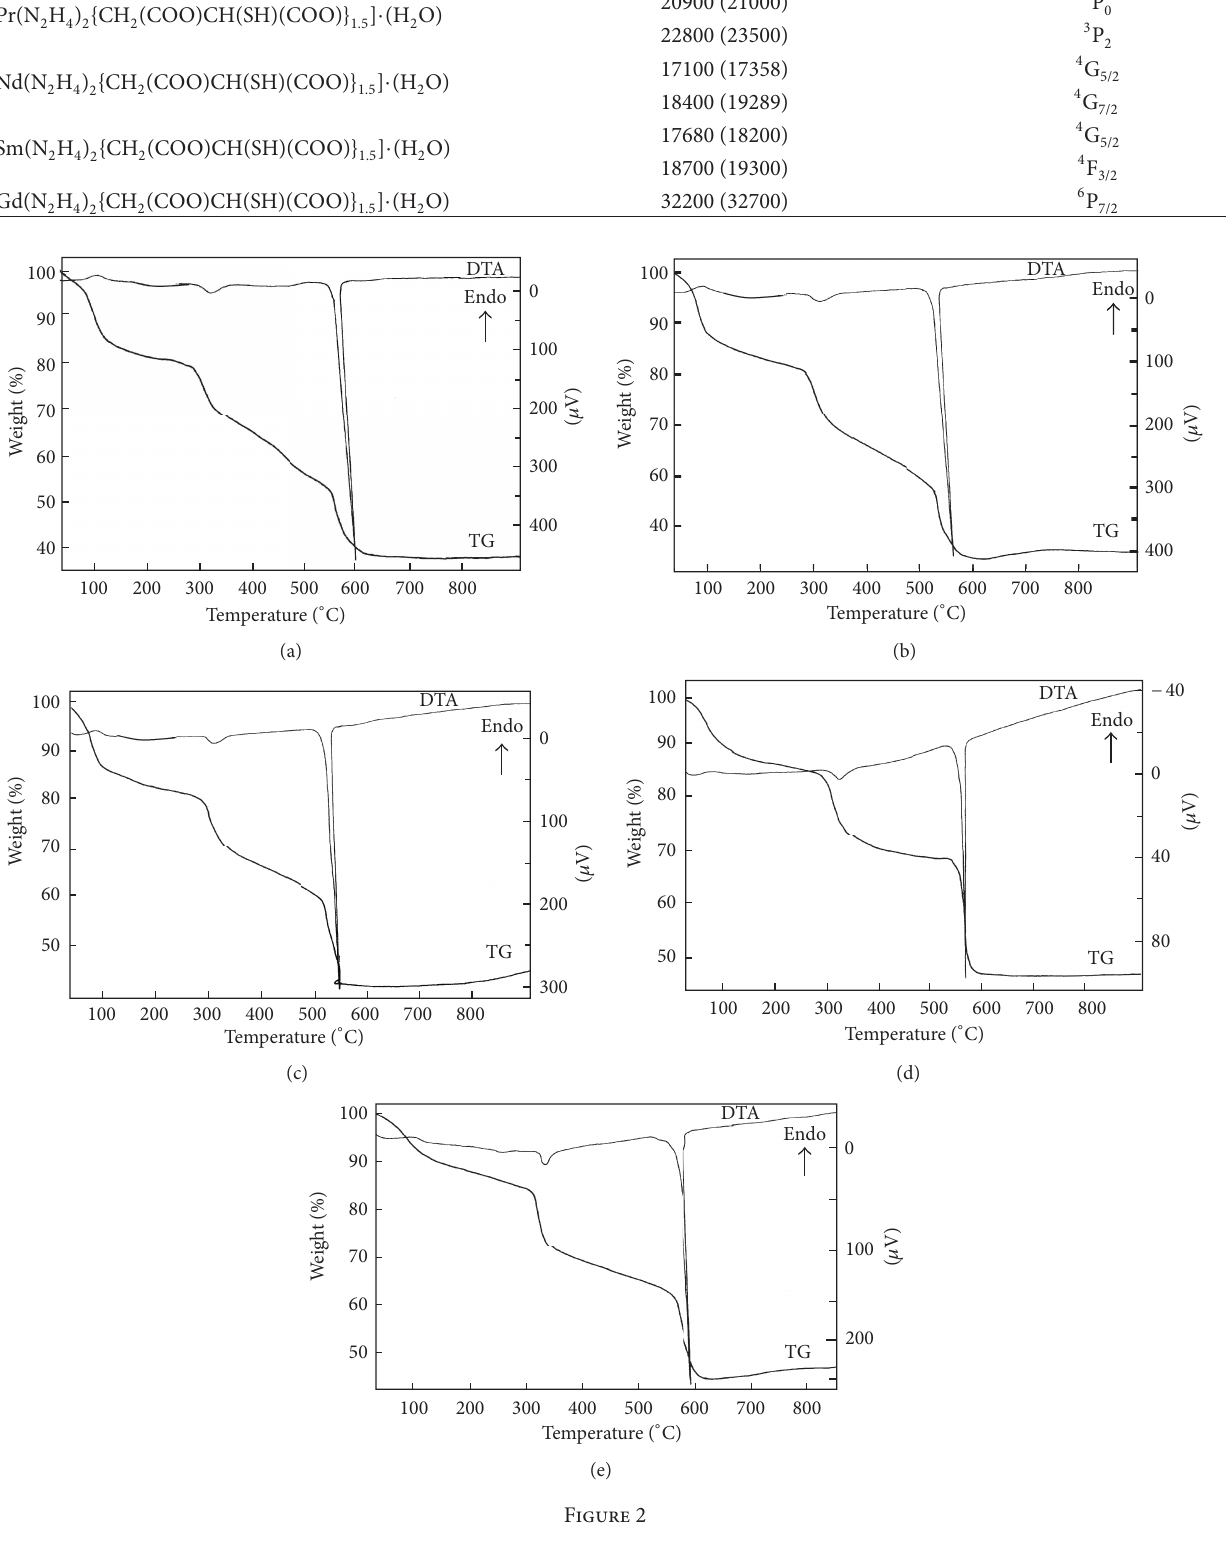
1 ) of the bands of −